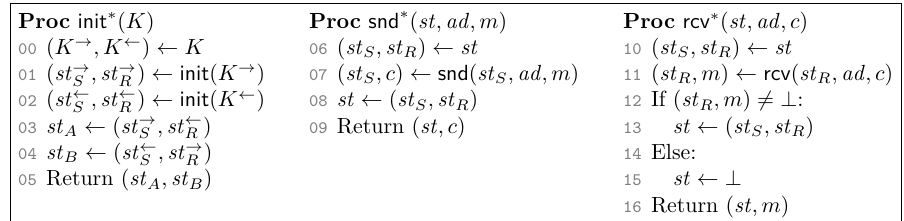
Figure 5: A bidirectional channel Ch ∗ = ( init ∗ , snd ∗ , rcv ∗ ) built from a unidirectional channel Ch = ( init , snd , rcv ) using the canonic composition